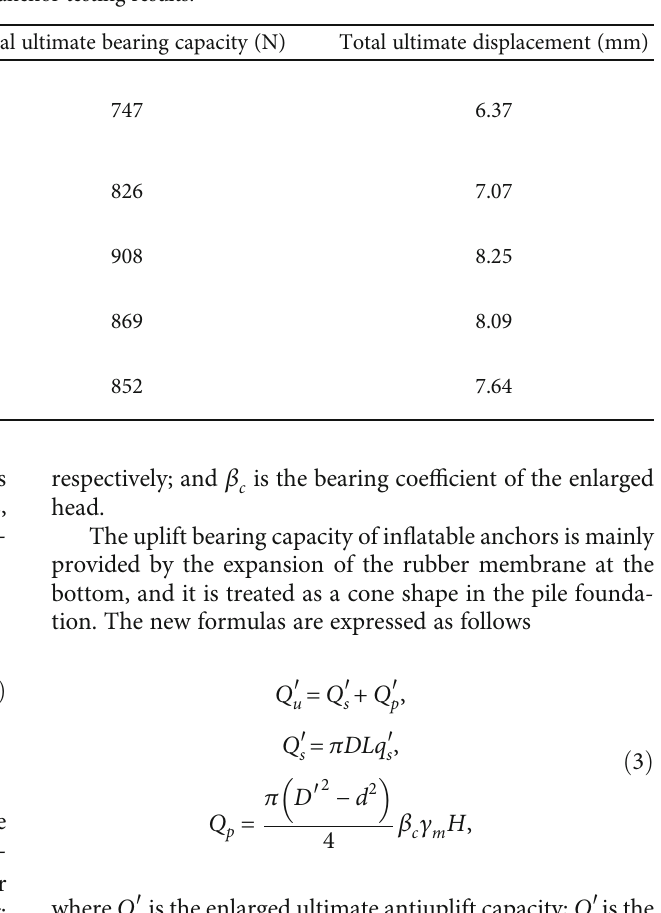
Figure 7: Q - S curves of multiple anchors with di ff erent spacing. Table 3: Two-anchor testing